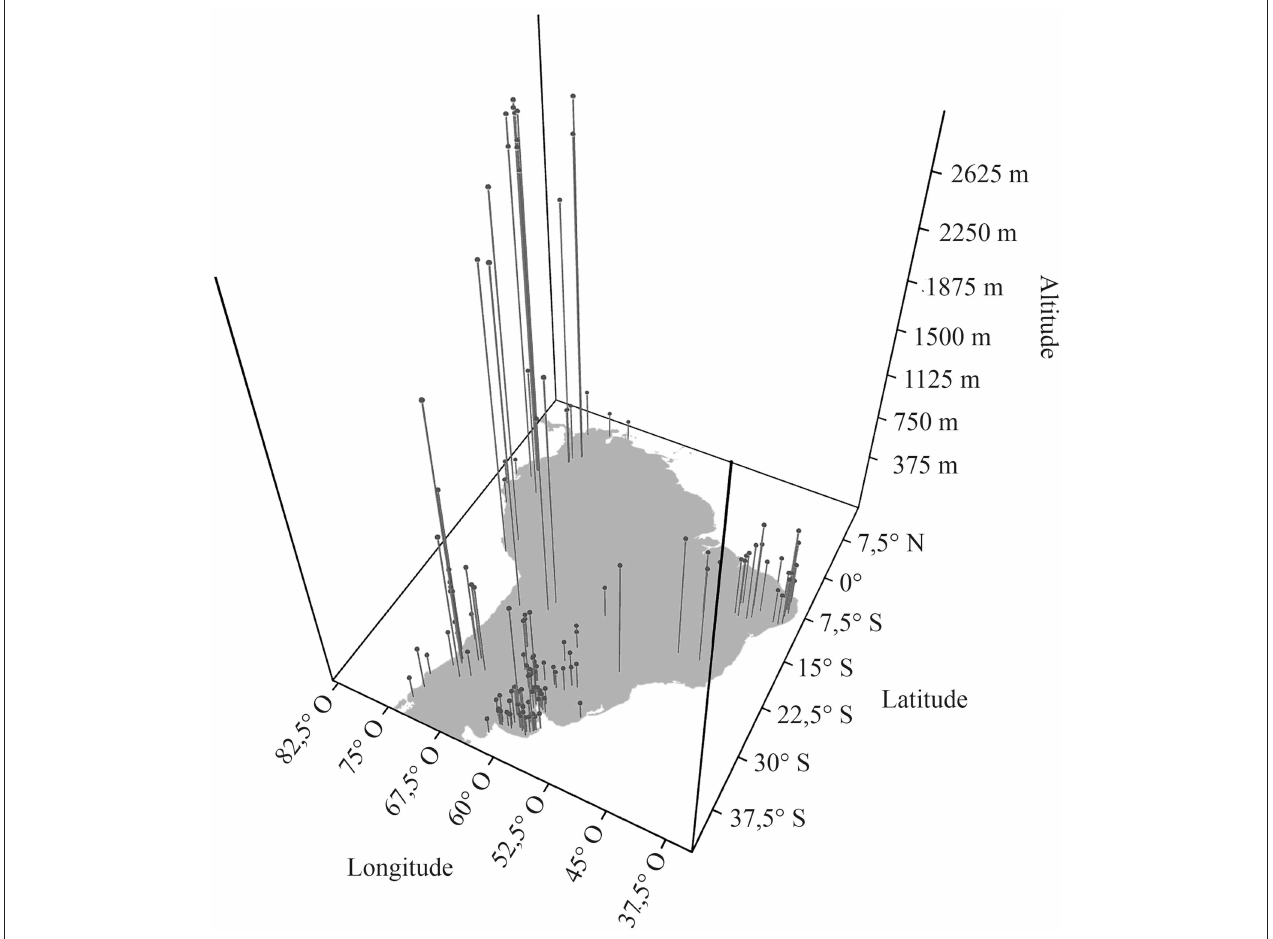
FIGURE 11 | Dispersal graph of the geographic coordinates and altitudes of South American Equus fossil